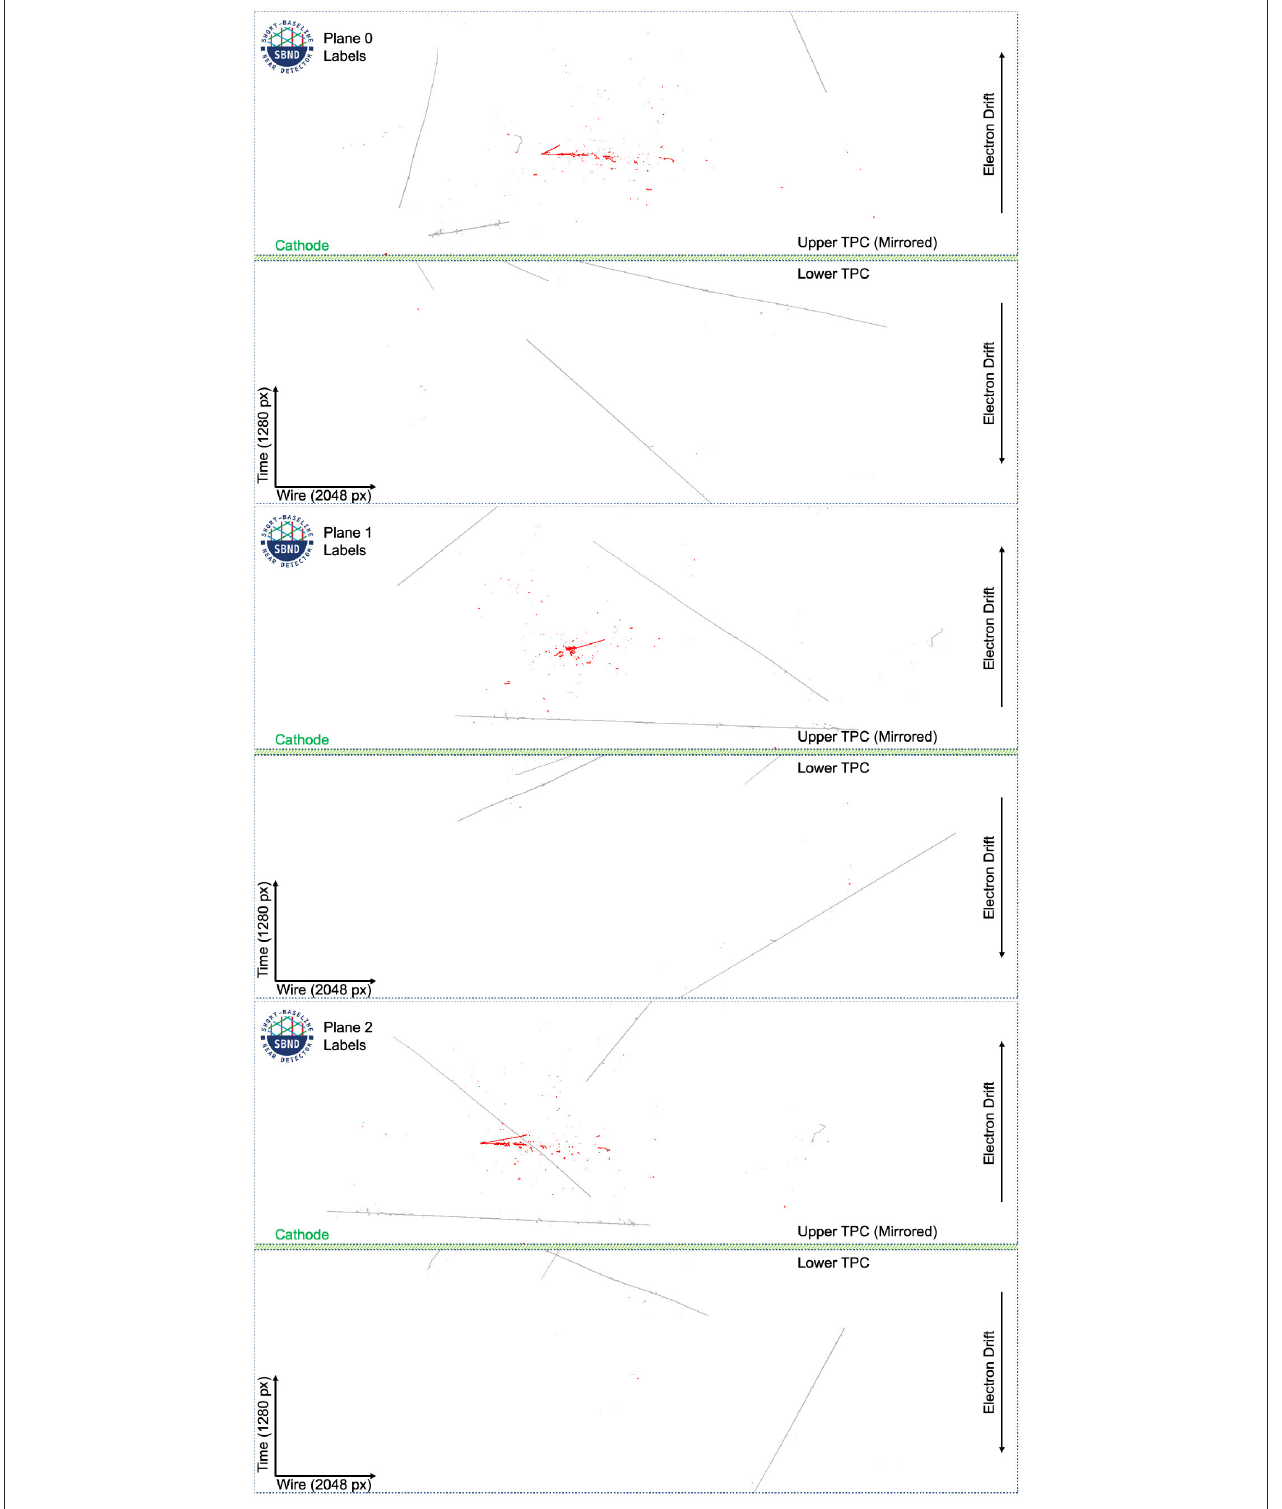
FIGURE 5 | The labels for the images in Figure 4 in the dataset at full resolution. White pixels are background, gray pixels are associated with cosmic particles, and red pixels are associated with a neutrino interaction. Plane 2 shows a case of overlap between cosmic and neutrino pixels.